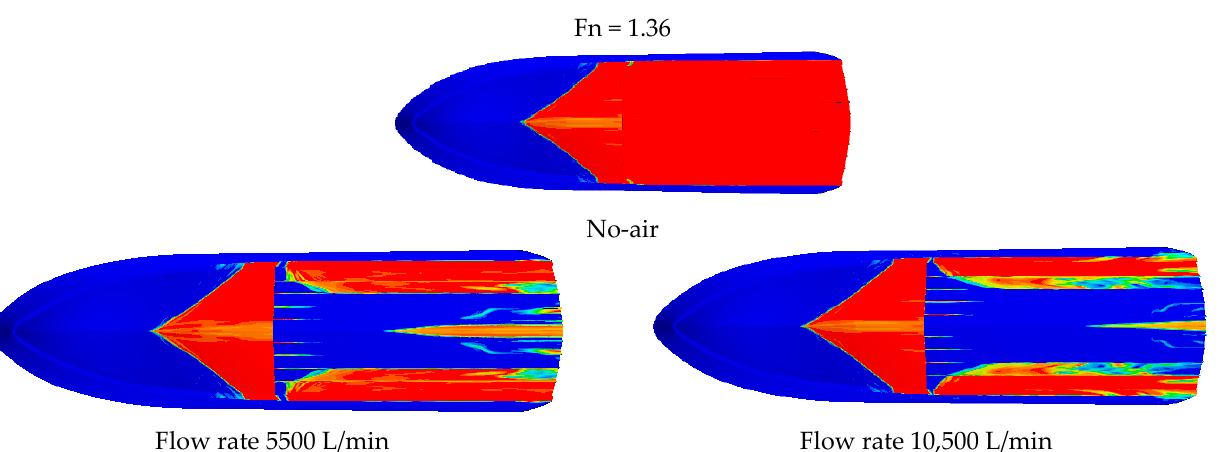
Figure 21. Wetted surface in three different conditions: no-air and injection of the air to the minimum and maximum flow rate.